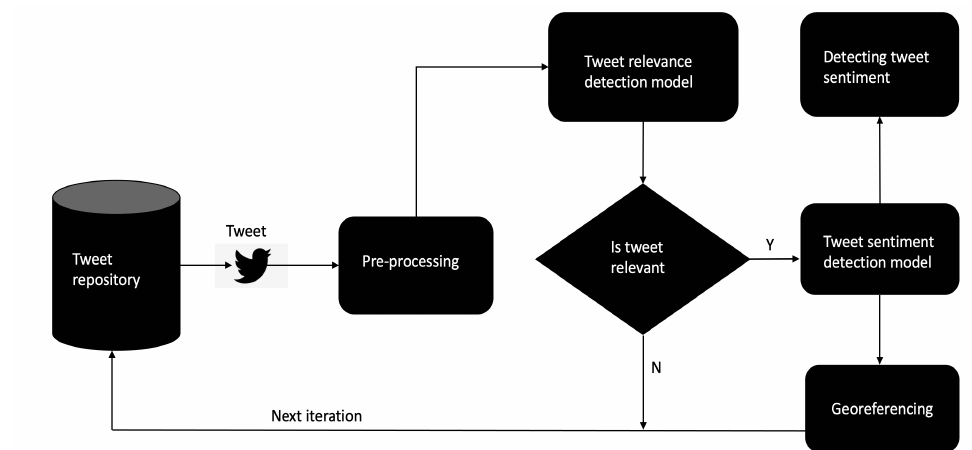
Figure 1. A schematic diagram showing the